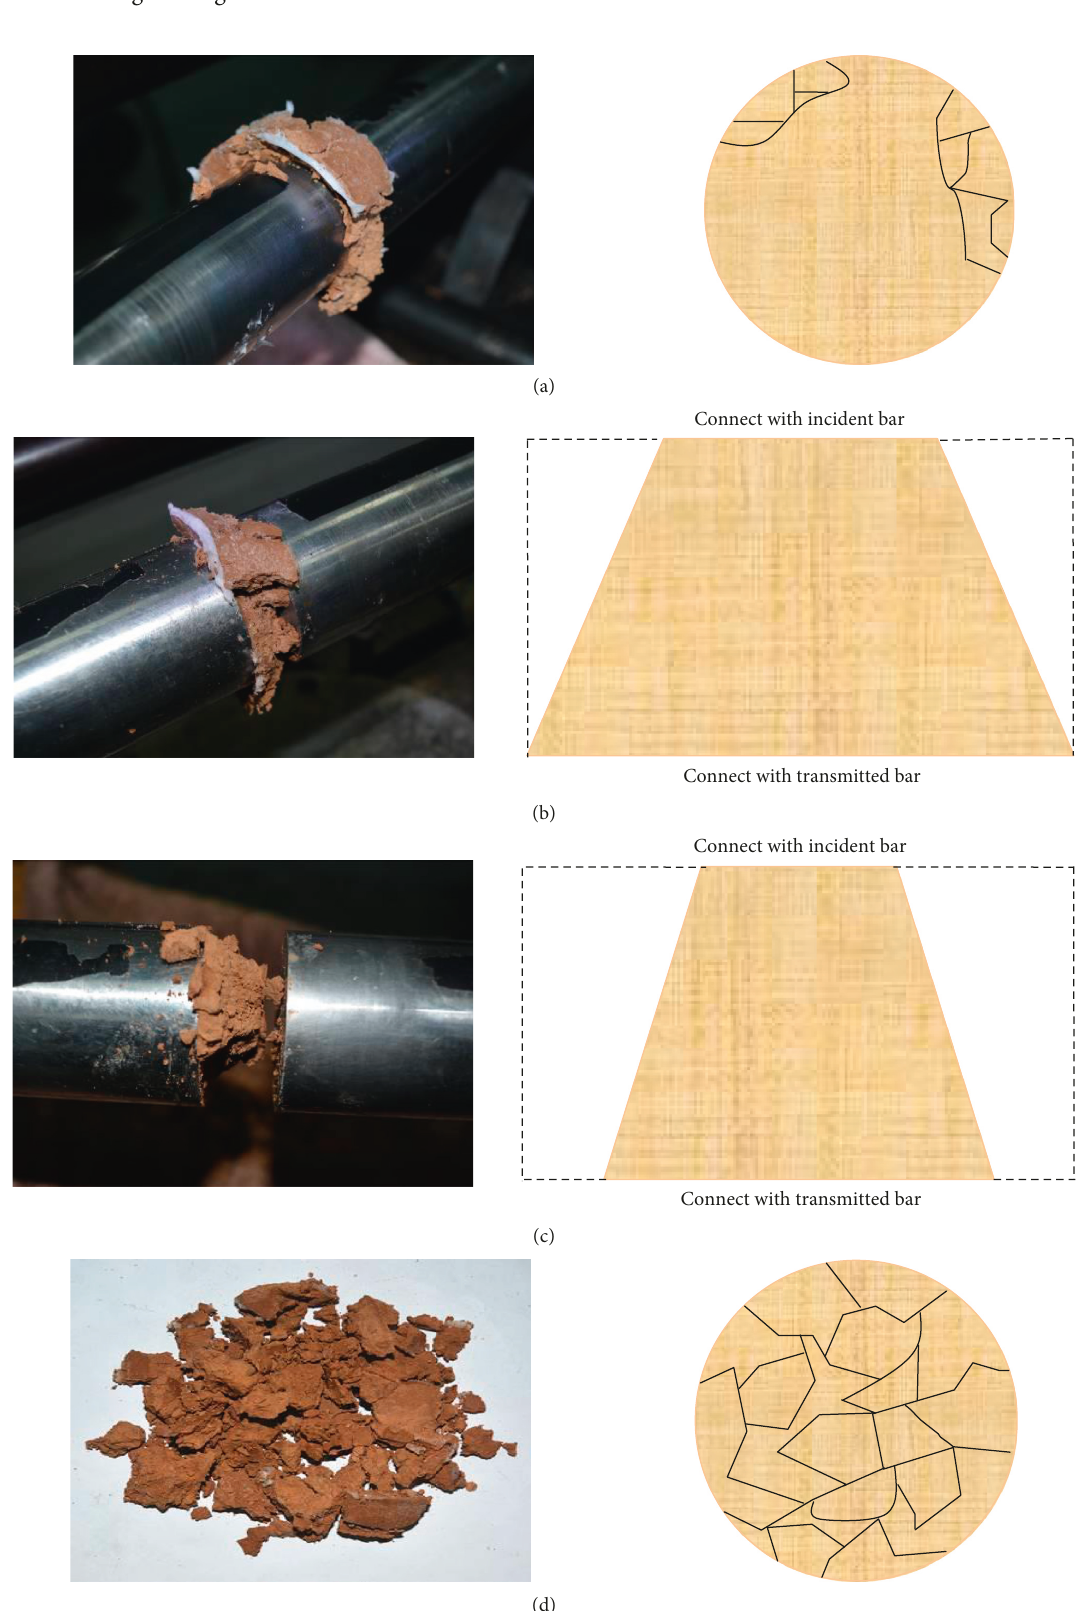
Figure 12: Failure modes of artificial frozen silty clay with different axial compressive stress ratios under one-dimensional coupled static and dynamic loads. (a) Failure mode of artificial frozen silty clay with 0.4 λ . (b) Failure mode of artificial frozen silty clay with 0.7 λ . (c) Failure mode of artificial frozen silty clay with 0.9 λ . (d) Failure mode of artificial frozen silty clay with 1.0 λ